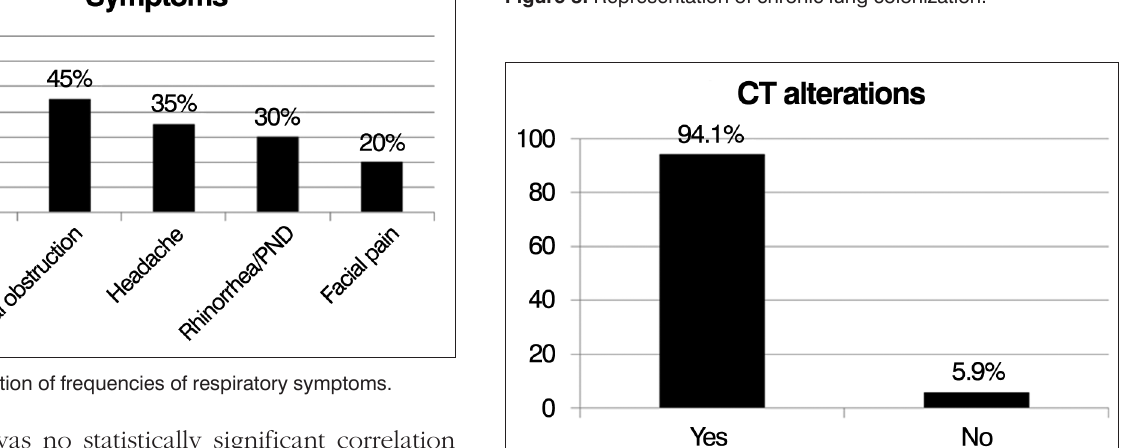
Figure 3. Representation of chronic lung colonization.